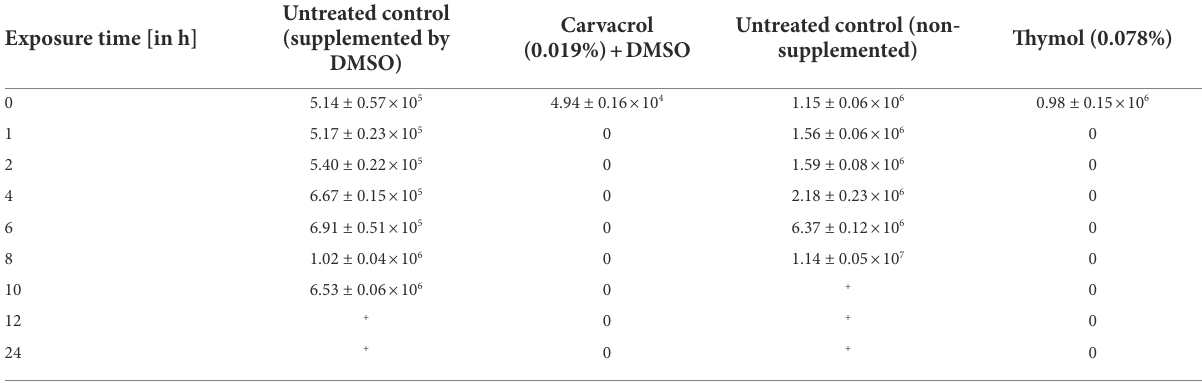
TABLE 5 Killing kinetics of carvacrol (0.0195%) and thymol (0.078%) to Xanthomonas campestris pv. campestris NCPPB 528 T at nine time points counted 48 h after the treatment [CFU mL − 1 ].